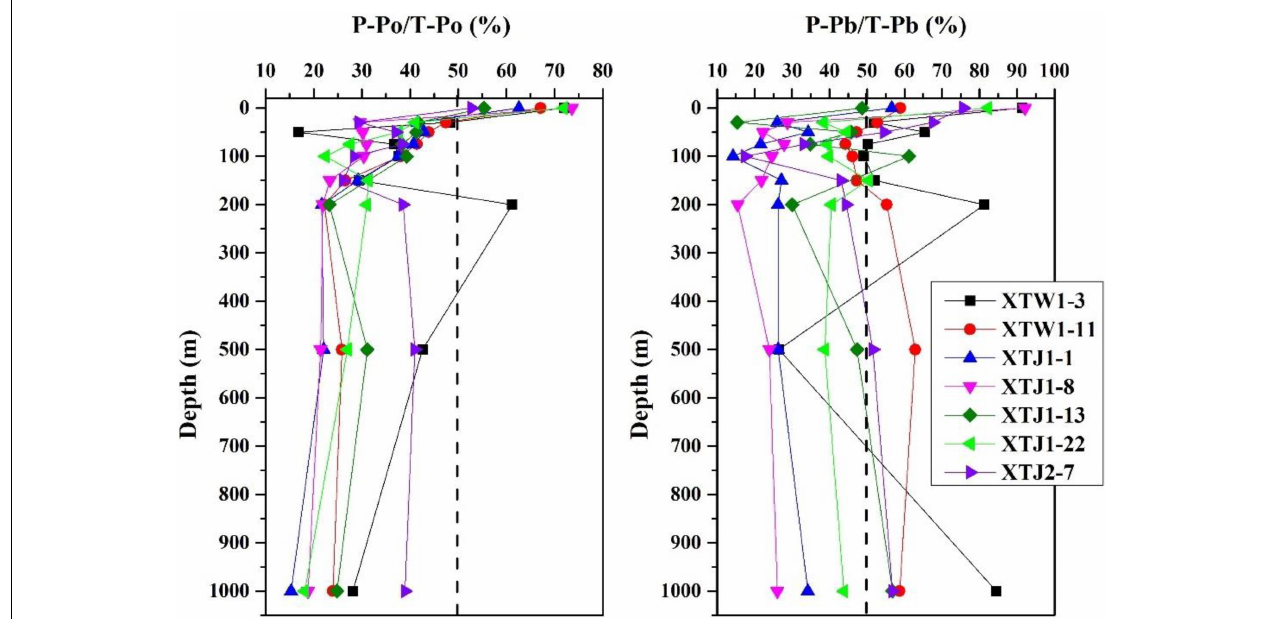
FIGURE 6 | Vertical profiles of percentage of particulate 210 Po and 210 Pb in water columns of the